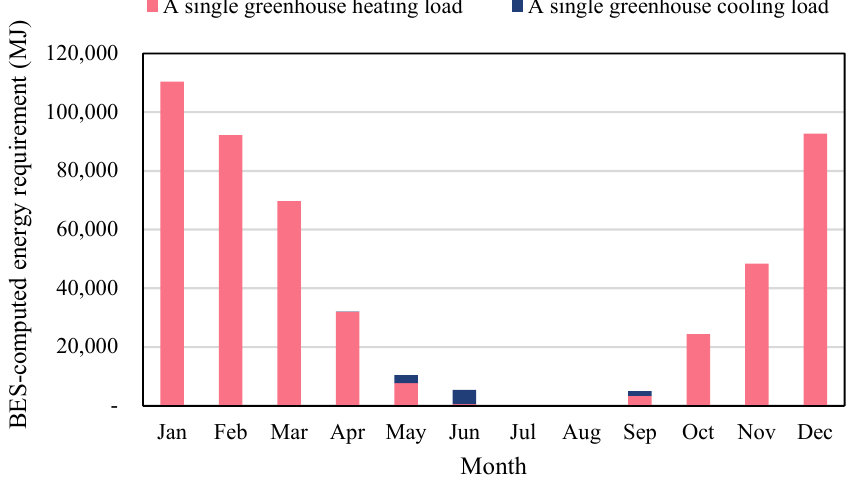
Figure 14. Monthly heating and cooling energy load in a single greenhouse with crop.